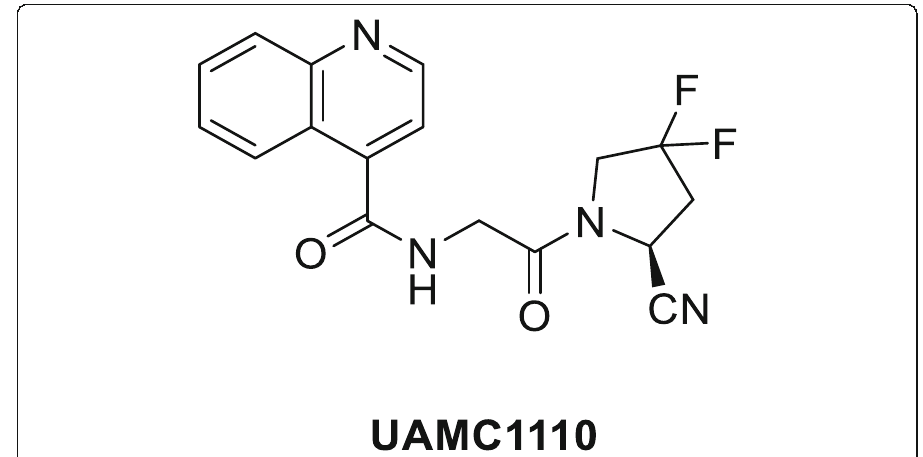
Fig. 1 FAP-inhibitor lead structure UAMC